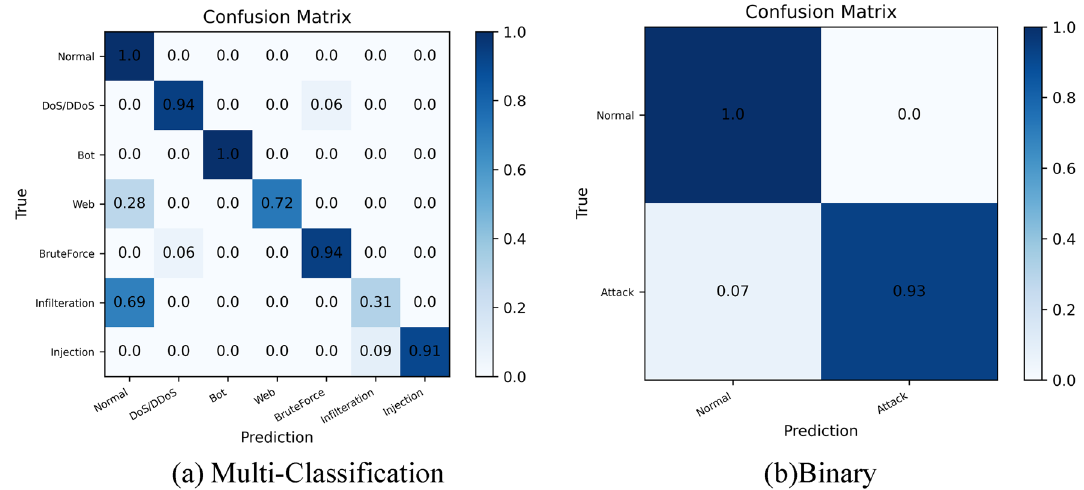
Figure 13. Confusion matrix diagram of the model. ( a ) Multi-category confusion matrix. ( b ) Binary confusion matrix.